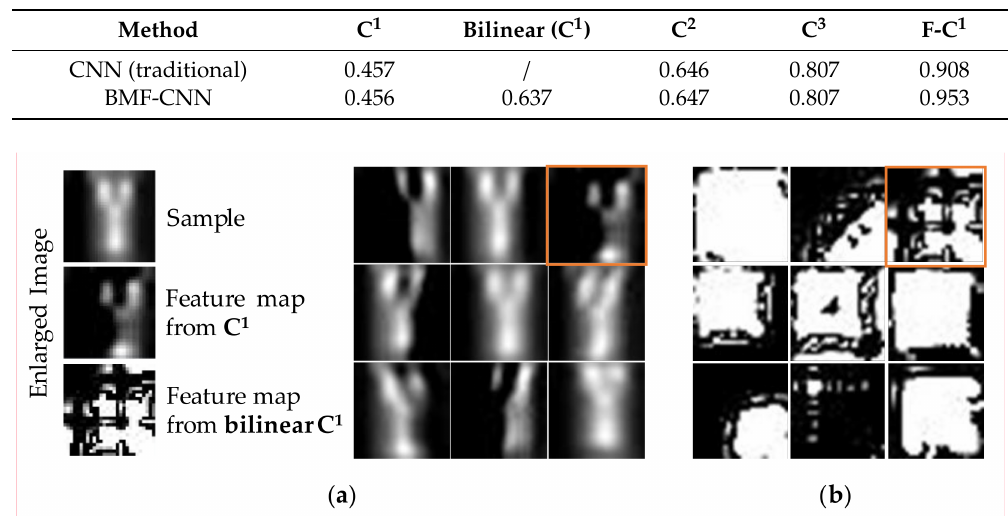
Table 3. The accuracy of di ff erent single layers.